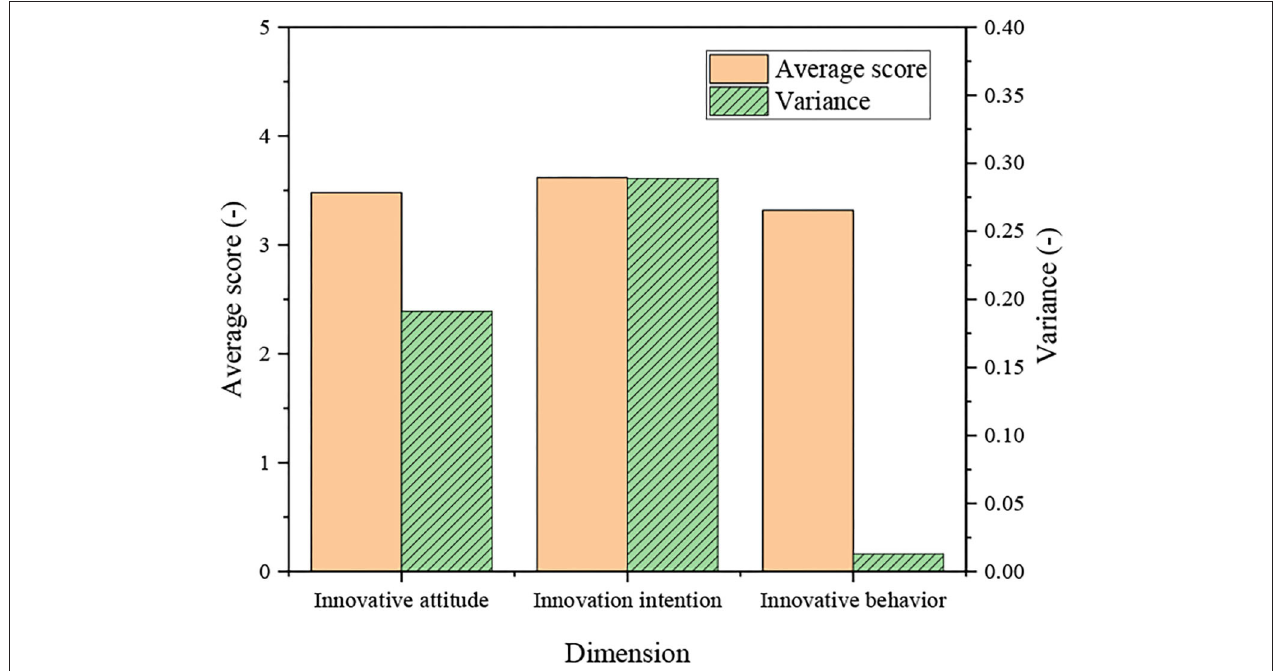
FIGURE 8 | Analysis of college-student entrepreneurs during work based on three dimensions.